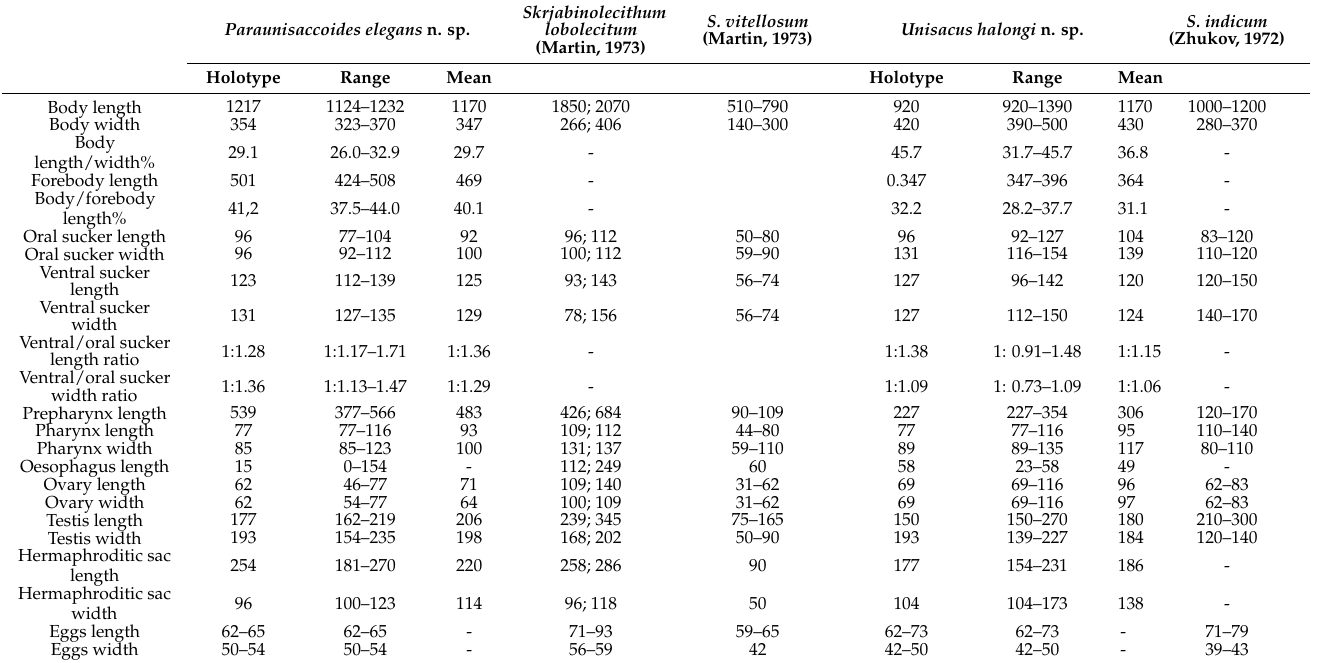
Table 2. Measurements ( µ m) of adult worms of new species Paraunisaccus elegans n. sp. and Unisaccus halongi n. sp. and known species Skrjabinolecithum lobolecithum and S. indicum . Paraunisaccoides elegans n.